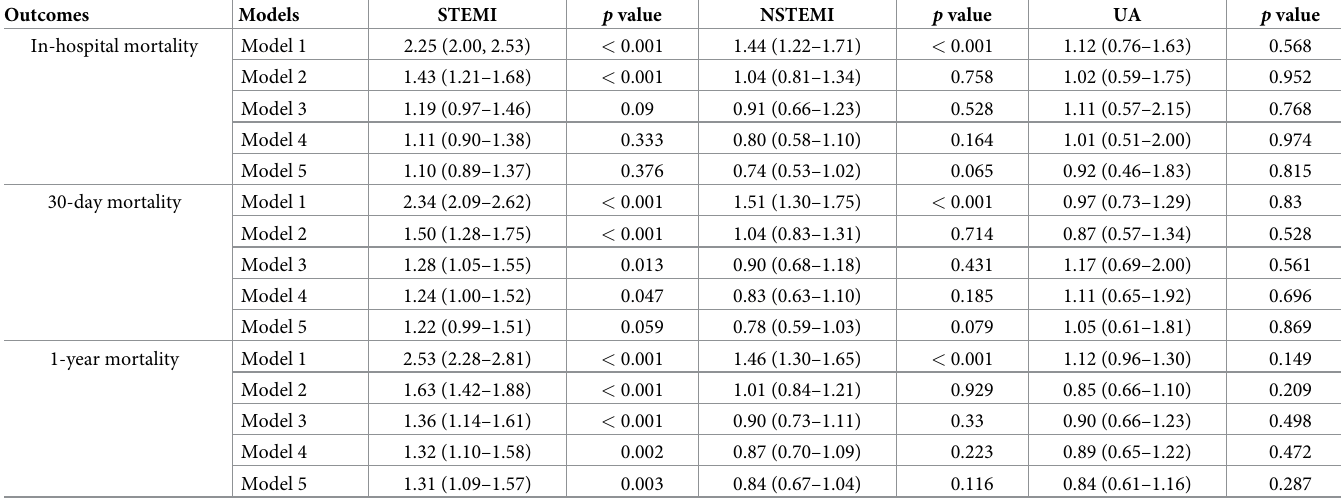
Values are OR (95% CI). Estimate for sex (women) was adjusted for other covariates. Model 1: Unadjusted logistic regression analysis including sex only (men as